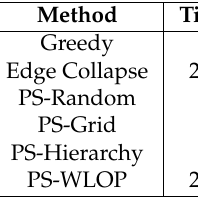
Table 5. Run times for generating the full pyramid of tiles using the different